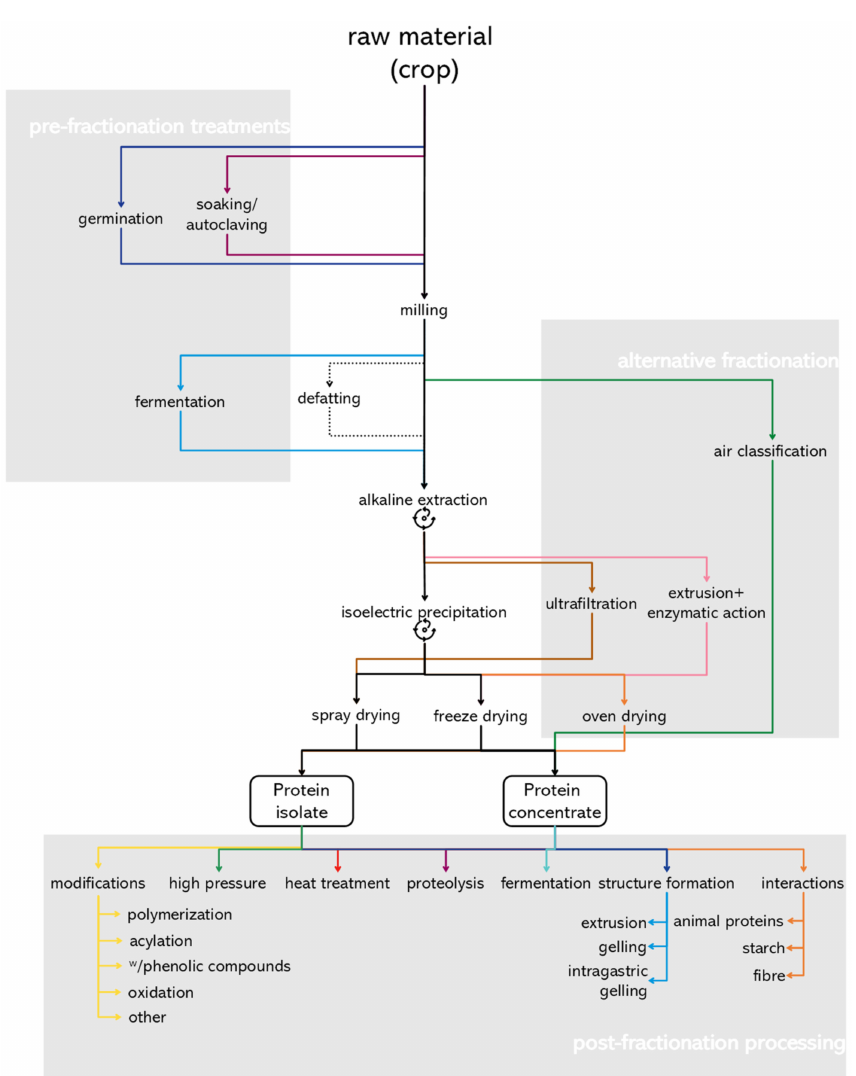
Figure 2. Overview of the processing steps before, during and after fractionation of plant proteins from the studies included in this review. Colours indicate the different routes for processing, the conventional route for aqueous fractionation is presented in black, and represents centrifugation after alkaline extraction and isoelectric